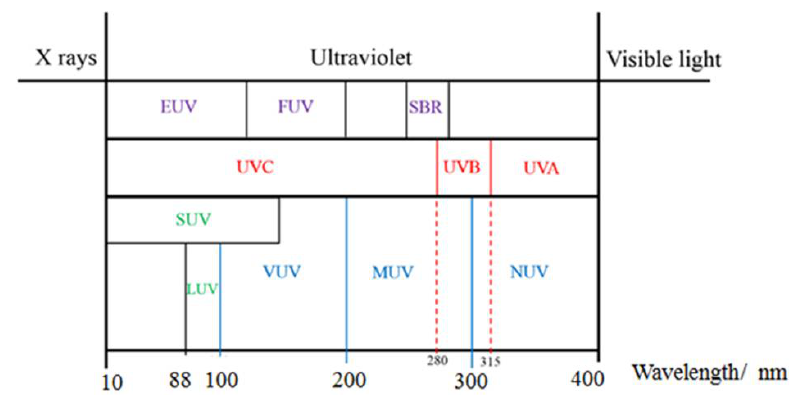
Figure 1. The classification of UV light.